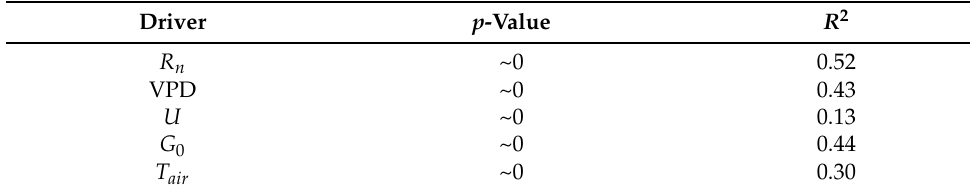
Table 6. R 2 of the univariate regressions of actual evapotranspiration against each considered driver using all the growing seasons without inter-annual distinctions. (All regressions are significant at 95% confidence level).